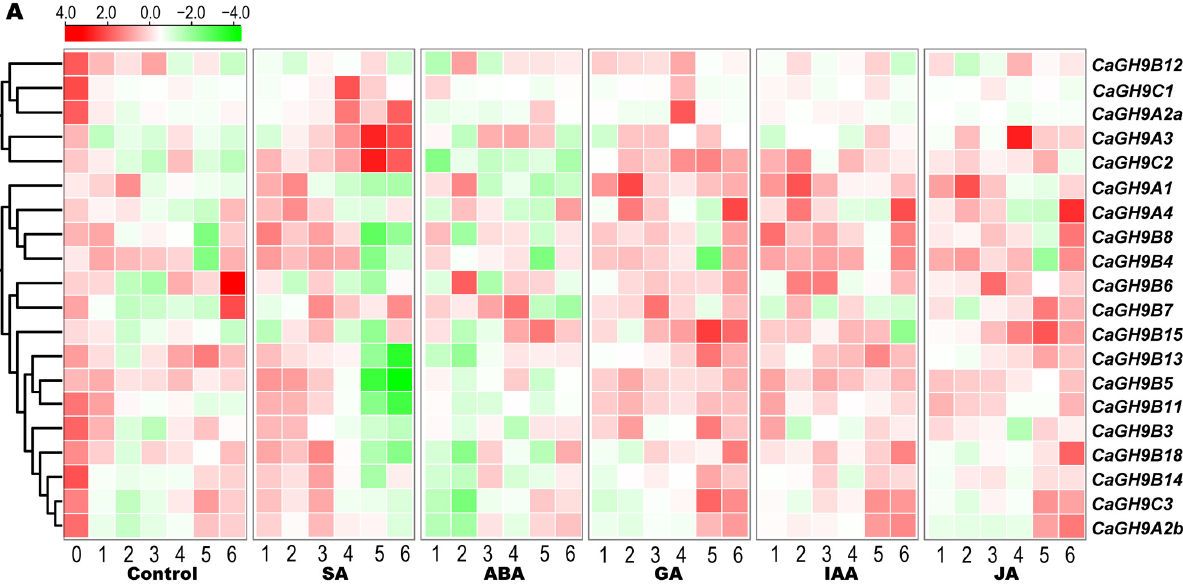
Figure 7. The expression patterns of GH9 family genes under the treatment of phytohormones ( A ) and stresses in pepper leaf ( B ). Log2 and row scale normalization were applied to the RNA ‐ seq based RPKM values, and the heatmap visualization was performed using TBtools. The numbers 0 – 6 represent different time points (0, 1.5, 3, 6, 12, 24 h) before (0) and after treatment. The color scale shows increasing expression level from green to red. SA, salicylic acid; ABA, abscisic acid; GA, gib ‐ berellin; IAA, indole ‐ 3 ‐ acetic acid; JA, jasmonic acid. RNA ‐ seq data were retrieved from Pep ‐ perHub. 2.10. Co ‐ Expressed Transcription Factor Genes Weighted correlation network analysis (WGCNA) is a powerful method to identify target genes, biomarkers and regulatory networks [34–36].To identify putative regulators of GH9B3, we conducted WGCNA analyses on the dynamic transcriptome data of tobacco